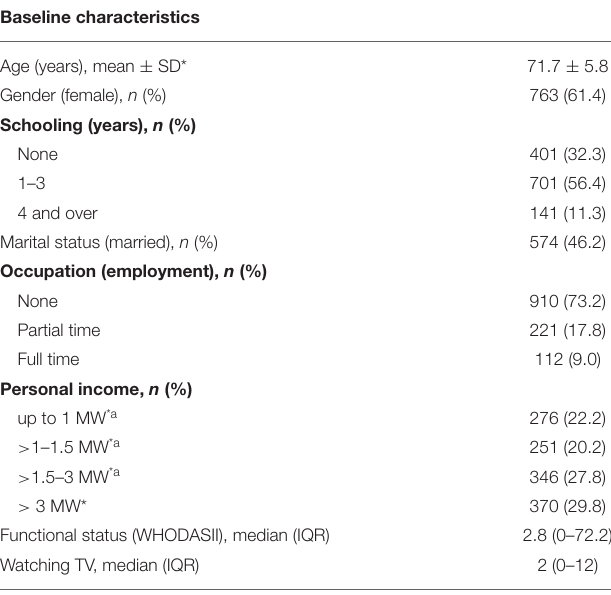
TABLE 1 | Sociodemographic and functional characteristics of the participants of the study ( n = 1,243). Baseline characteristics